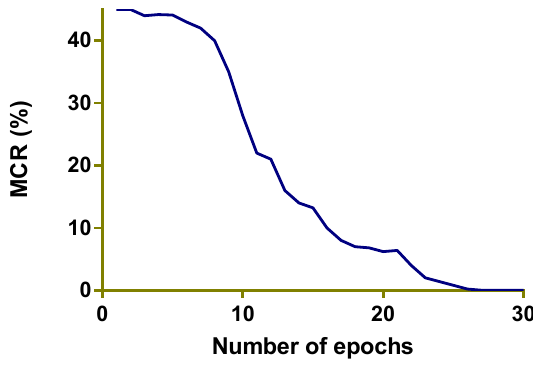
Figure 7. The mis-classification rate (%) for training data (for HELEN [28] database